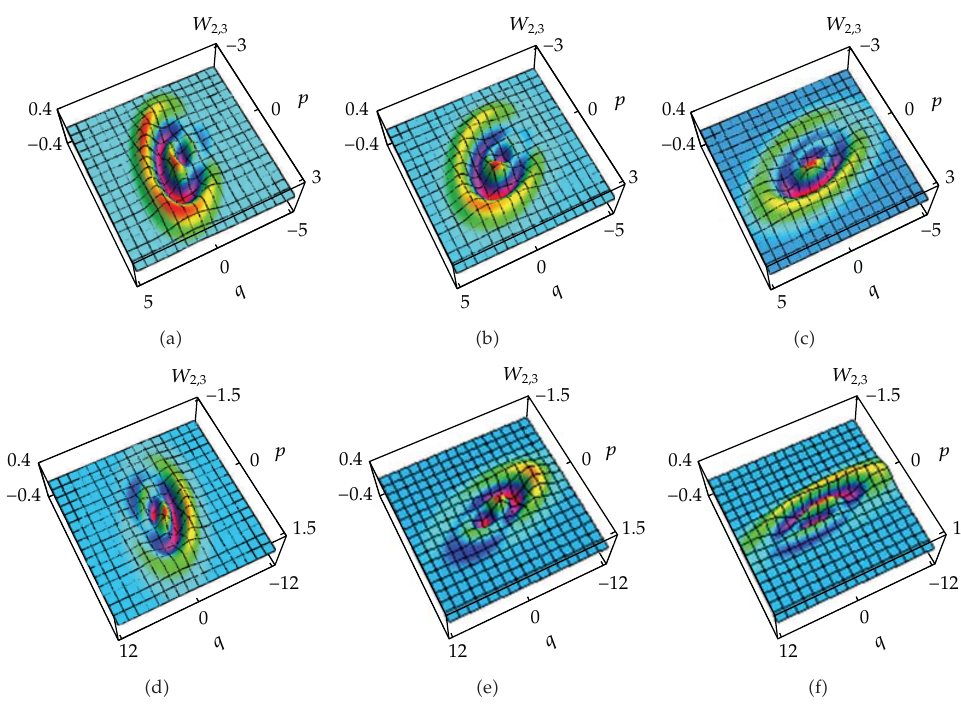
√ 2 (cid:5)(cid:4) | 2 (cid:4) (cid:9) | 3 (cid:4) (cid:5) at t 0 and at successive times; δ 0 (cid:8) 0 .